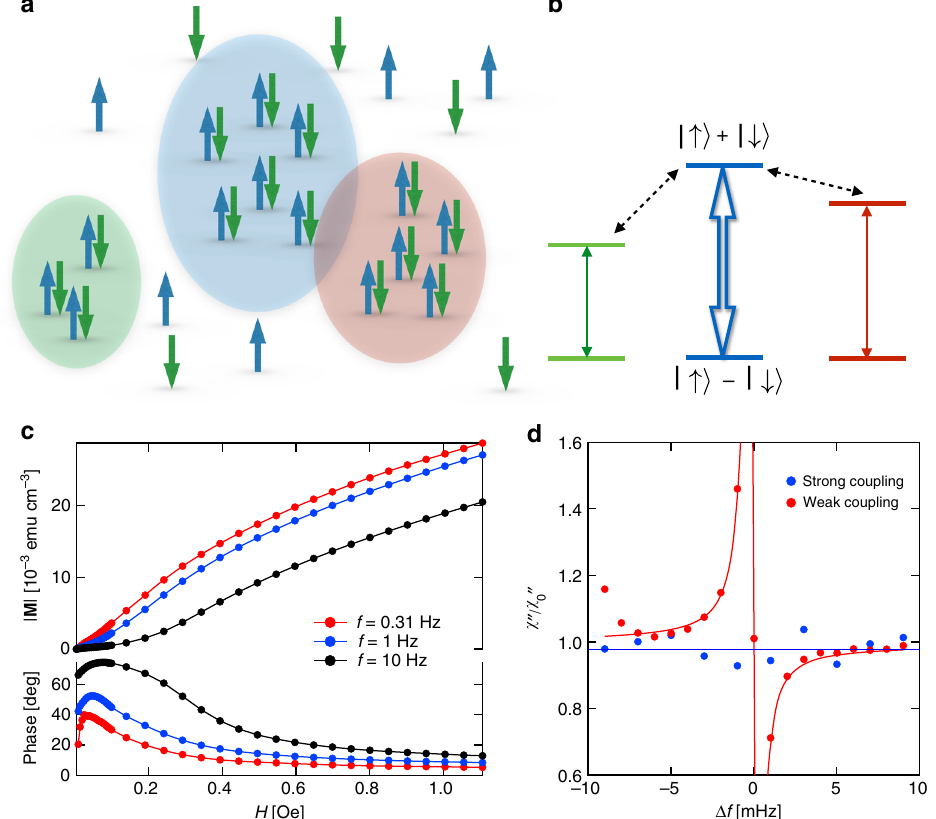
Fig. 1 Schematic of spin con fi guration and transition pathways in pumped LiHo 0.045 Y 0.955 F 4 . a Tightly bound spin clusters embedded in a dilute spin bath. Closely separated spins form a tightly bound cluster, which can be magnetized in a nonlinear response regime by a strong ac pump fi eld. Spatially adjacent clusters can interact directly. b Schematic of cluster excitation pathways. Clusters of different sizes have different energy gaps, so the choice of pump frequency acts as a size selector. Direct interactions between excited clusters and off-resonance clusters give rise to Fano resonance behavior. c Magnetization amplitude (top) and phase angle (bottom) for three different excitation frequencies. d Pump-probe measurements (ratios of imaginary part of response χ '' in presence of pump to response χ '' 0 without pump) in two thermodynamic regimes. When LiHo 0.045 Y 0.955 F 4 is weakly coupled to an external heat reservoir, the low-temperature state is dominated by the quantum cluster response, giving rise to strong Fano resonances. When it is strongly coupled to an external heat reservoir, it exhibits extended glassy behavior including the absence of hole-burning and Fano resonance effects 25 . Both traces were measured at T = 100 mK, f pump = 20 Hz, and h pump = 0.5